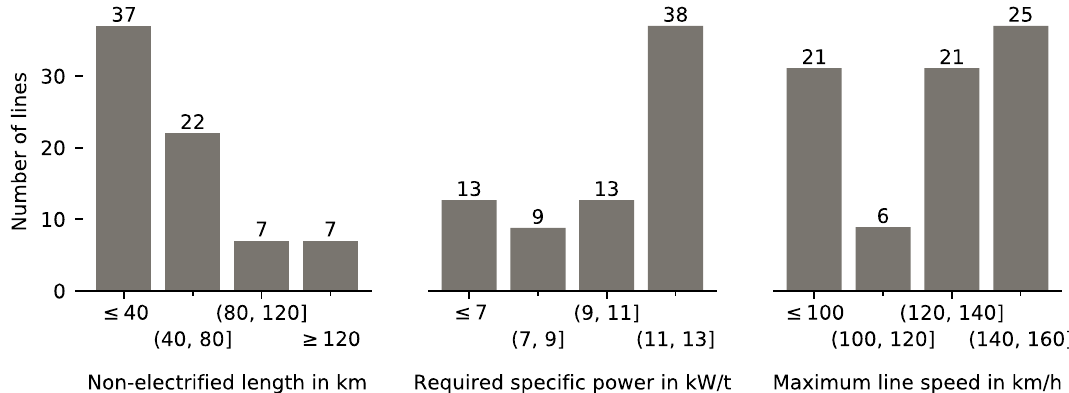
Figure 2. Distributions of requirements for range, specific power, and maximum